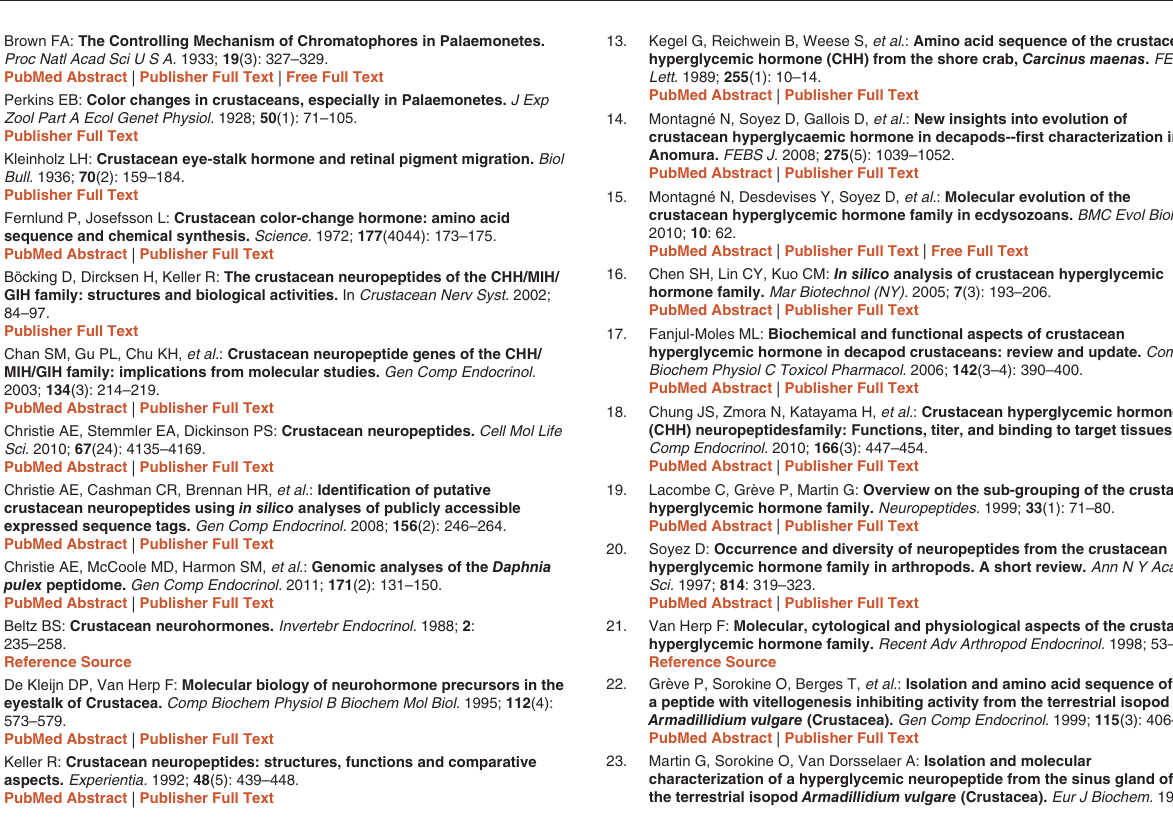
Supplementary Table 1: List of accession numbers for species used in this study. Click here to access the data. Supplementary Table 2: Protein distance matrix (% identity) constructed from a multiple sequence alignment of CHH/MIH/GIH